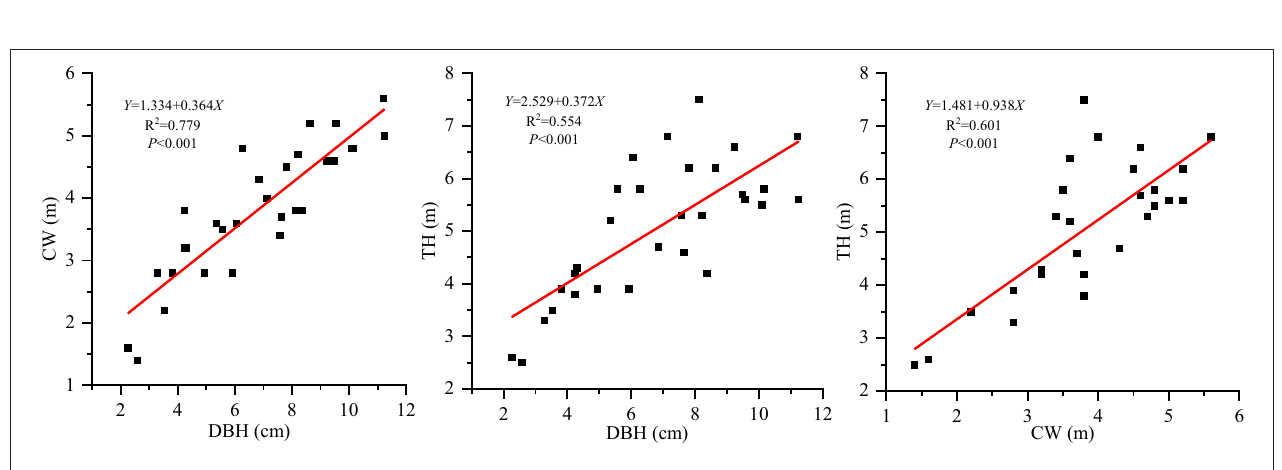
FIGURE 4 | Correlation analysis among plant size indicators of Sapindus mukorossi